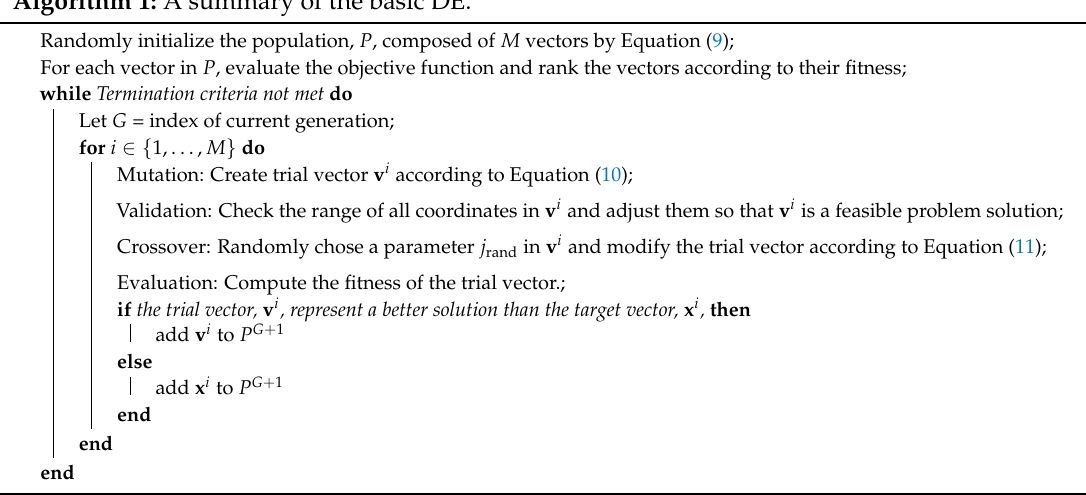
Algorithm 1: A summary of the basic